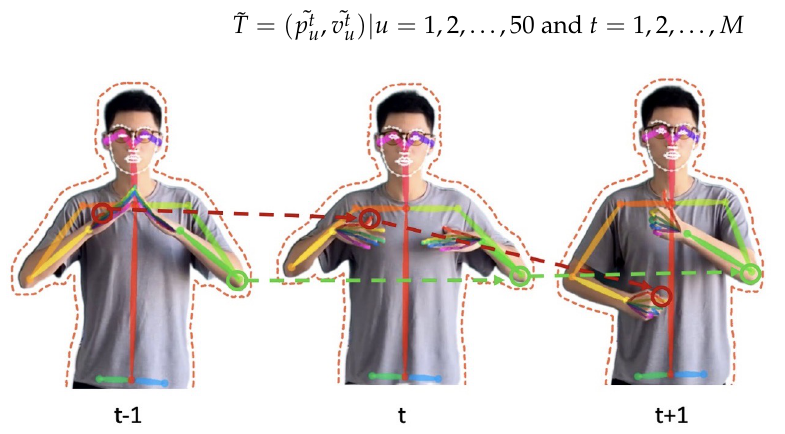
Figure 2. Exploiting Dynamic Information. For example, the red line indicates the motion information of the thumb joint at t − 1, t and t + 1, and the green line indicates the corresponding motion of the elbow joint. The dynamics of joints are defined by the position and velocity information, which implies the spatial displacement of joints with the frame